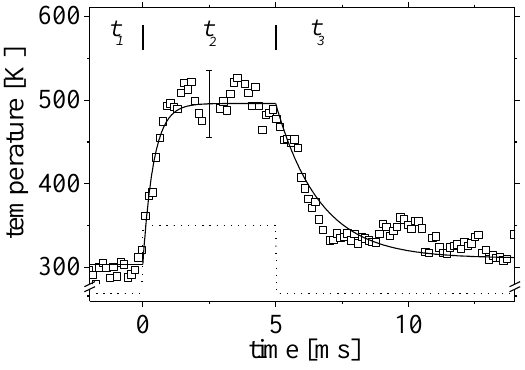
Figure 3. Calculated temporal evolution of the temperature of NO diluted in air (symbols) for a 150 mA plasma pulse. Exponential functions have been fitted to the temperature rise during the pulse, t 2 , as well as to the cooling period after the plasma pulse, t 3 [50], © IOP Publishing. Reproduced with permission. All rights reserved.